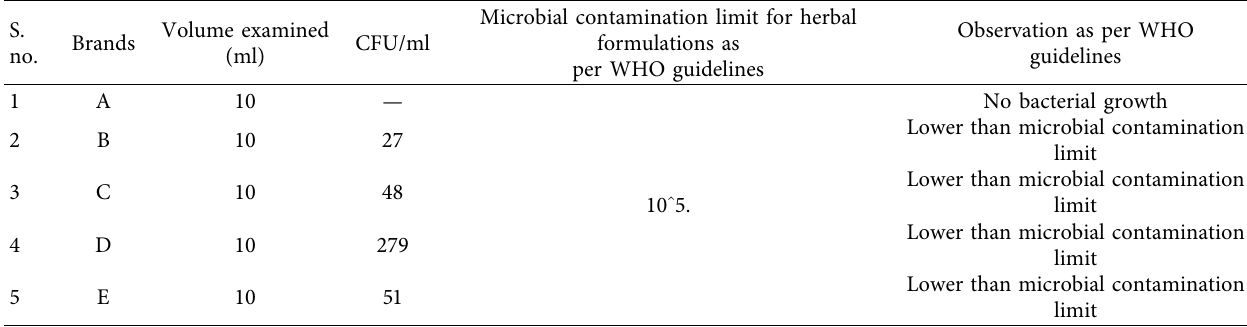
Table 4: Determination of total viable aerobic count in Chyawanprash.